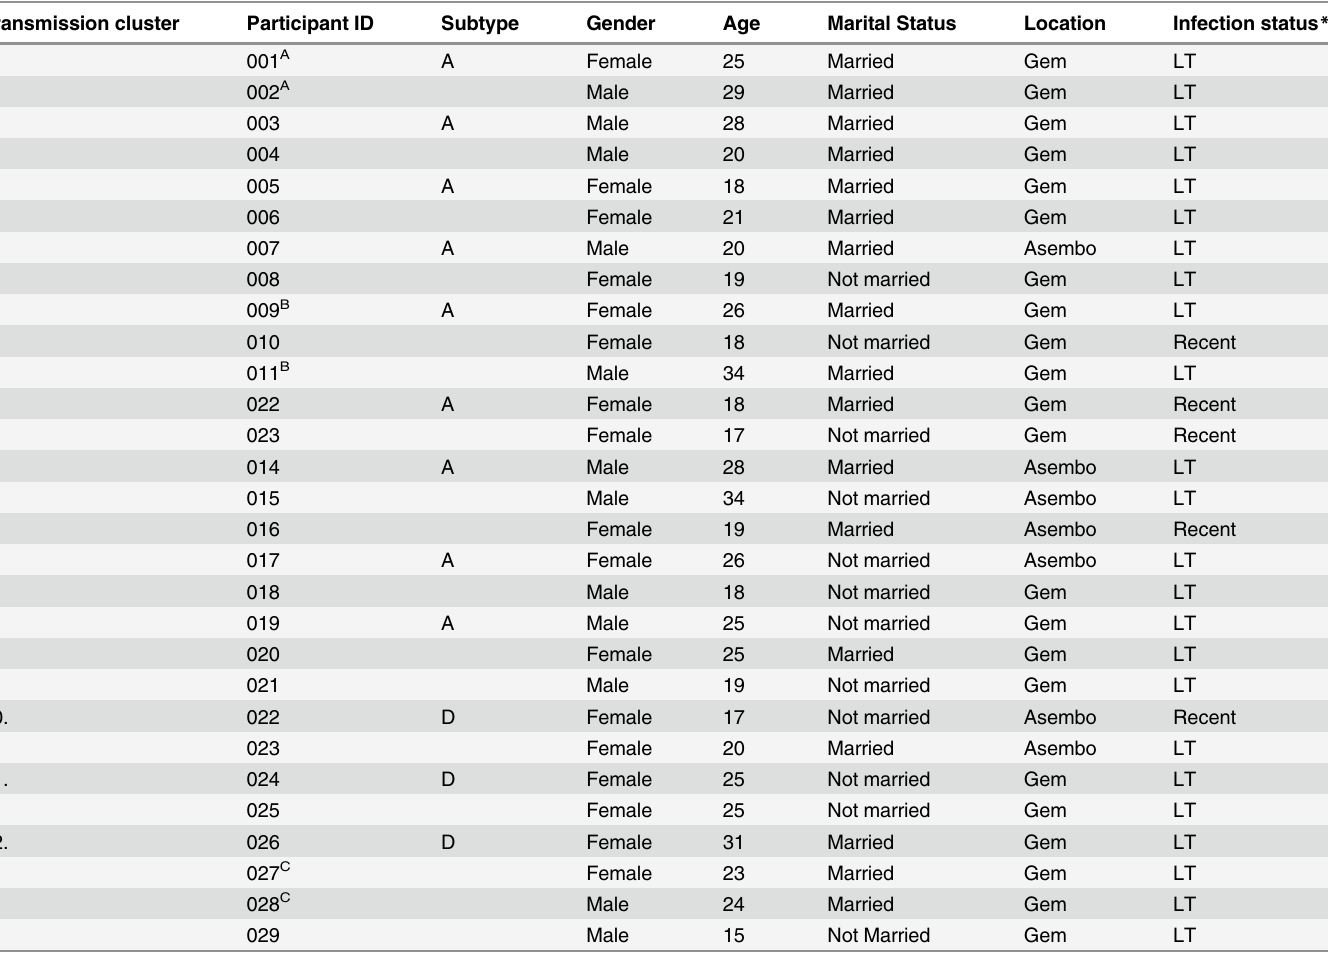
Table 4. Demographic characteristics of HIV-infected participants, by genetic cluster of HIV-1 strains, Western Kenya, October 2003 – May 2005. Transmission